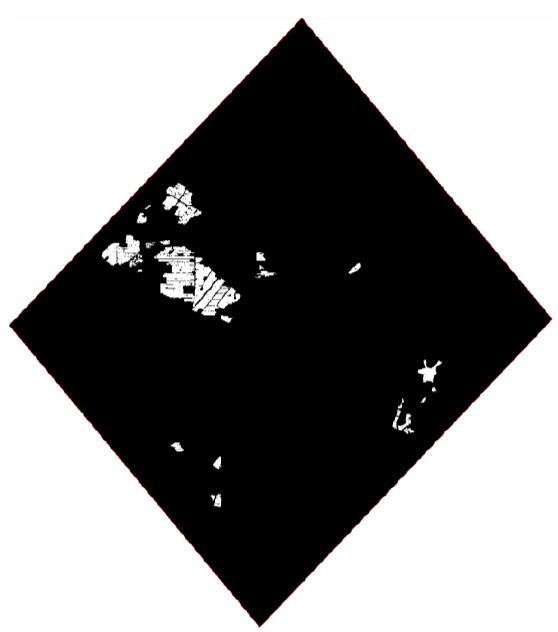
Figure 13: Target map of photovoltaic panels (after